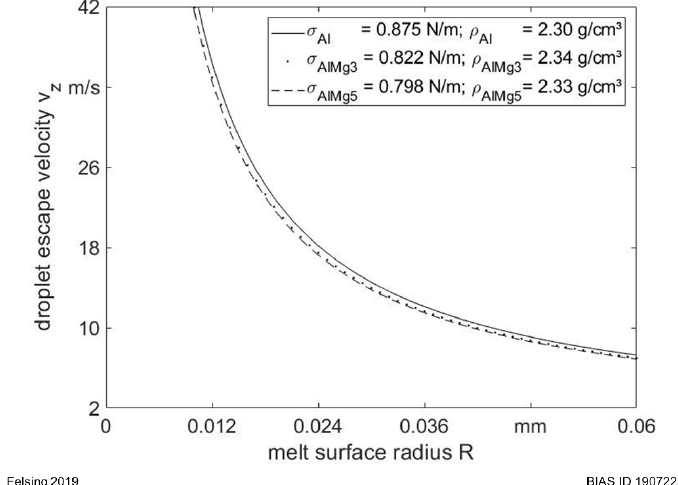
Figure 1. Influence of melt surface radius on minimal droplet escape velocity for Al, AlMg3, and AlMg5 at 973 K (Data for surface tension and densities taken from: [13,14]).